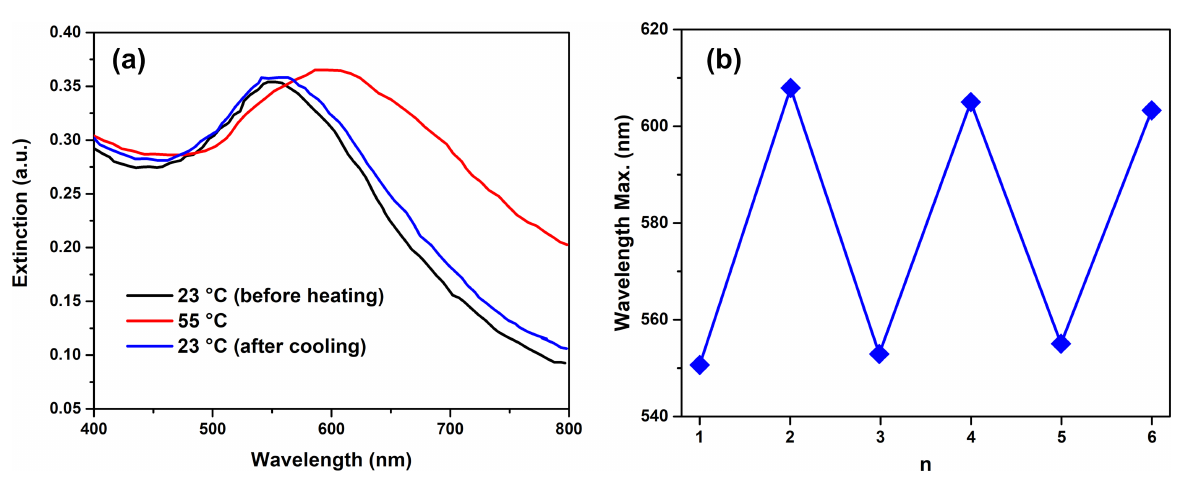
Figure 3: (a) UV–vis spectra of THPC gold seeds on swelled and collapsed pNIPAM- co -AAc hydrogel particles at 23 °C and 55 °C, respectively; (b) Swelling and collapsing of THPC gold seeds on pNIPAM- co -AAc hydrogel particles at 23 °C and 55 °C as a function of extinction